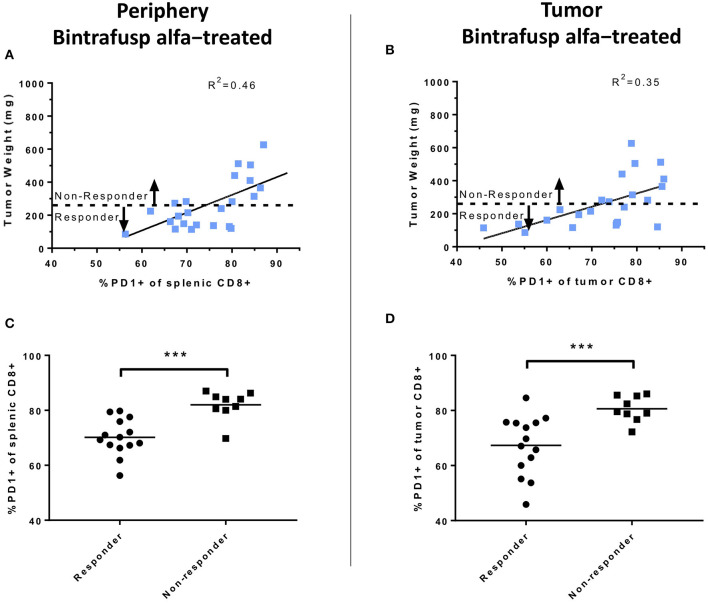
Analyses of peripheral and intratumoral CD8+ T-cell PD1 expression following bintrafusp alfa administration. (A) Association between PD1 expression in splenic (A) or intratumoral (B) CD8+ T cells vs. tumor weight at day 21 post-initiation of bintrafusp alfa treatment in bintrafusp alfa-treated PBMC humanized mice. (C) Splenic or (D) tumor CD8+ PD1 expression in animals responding to bintrafusp alfa (tumor weight <263 mg) vs. those not responding (tumor weight >263 mg) in HTB-1 humanized mice (***p < 0.0001, student's t-test).